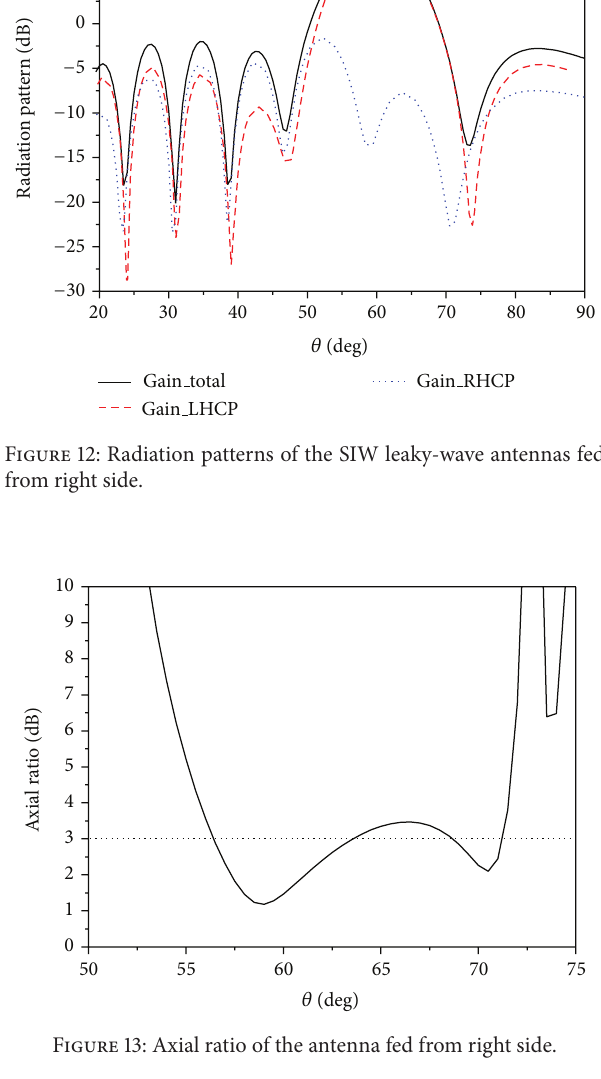
Figure 11: Radiation patterns of the SIW leaky-wave antennas fed from left side.